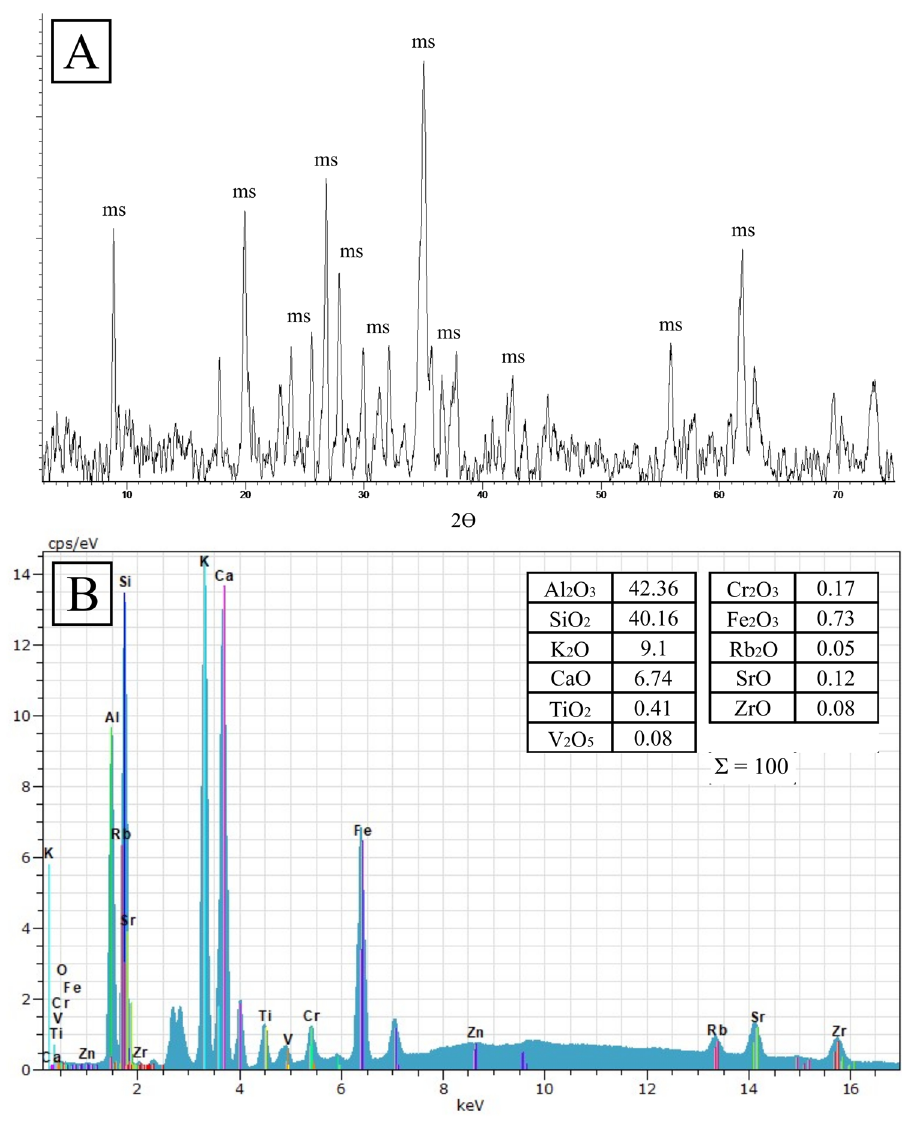
Figure 10. ( A ): X-ray diffractogram X (Ms: muscovite) and ( B ) X-ray microfluorescense spectrum from the surface of the green bead from E2T13B, with quantitative chemical analysis by mXRF (oxides